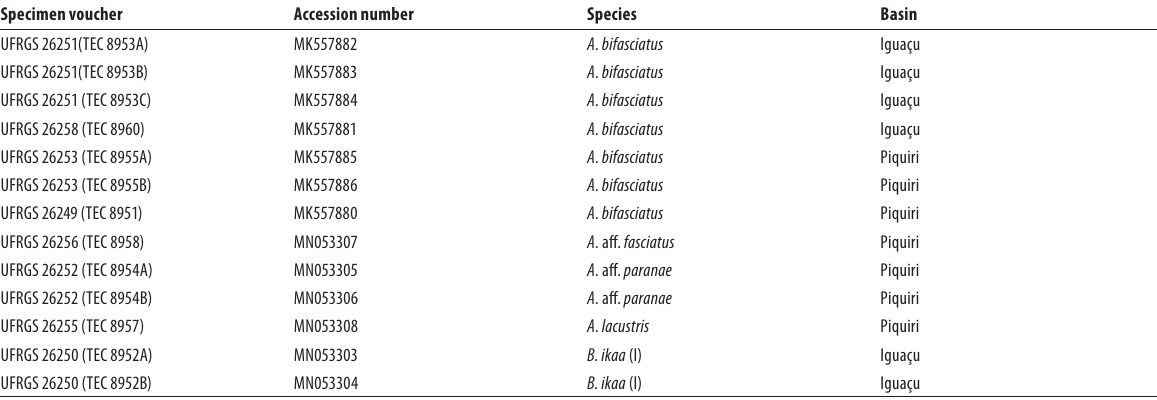
Table A1. Voucher number and genetic sequences accession numbers (GenBank) of Astyanax bifasciatus specimens and other syntopic Characidae species from the basins of the lower Iguaçu River and Piquiri River (upper Paraná river basin) generated in this study.